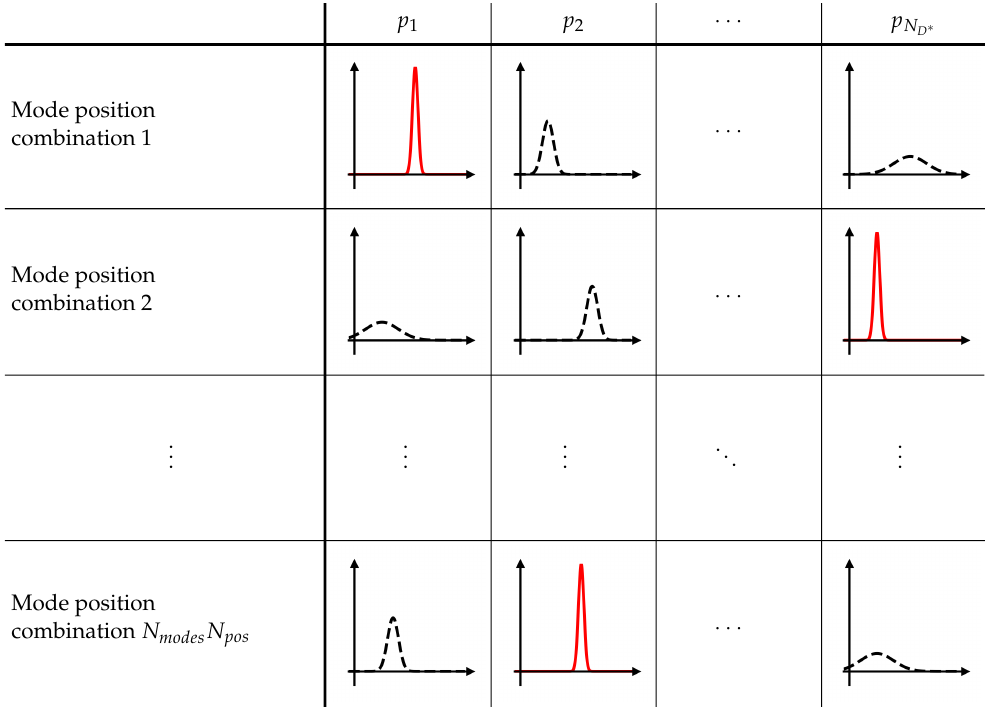
Figure 2. Exemplary depiction of the brute-force identification results for overcoming local minima; for each position–mode combination, an optimization problem searching for the unknown stiffness model parameters is set up and repeated, leading to different values due to local minima. The position–mode combination with the least standard deviation across all repetitions yields the final identified value for each parameter. This is indicated by red solid lines instead of black dashed